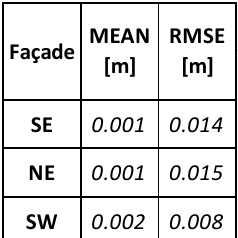
Table 14. CloudCompare statistical parameters between photogrammetric meshes and TLS point